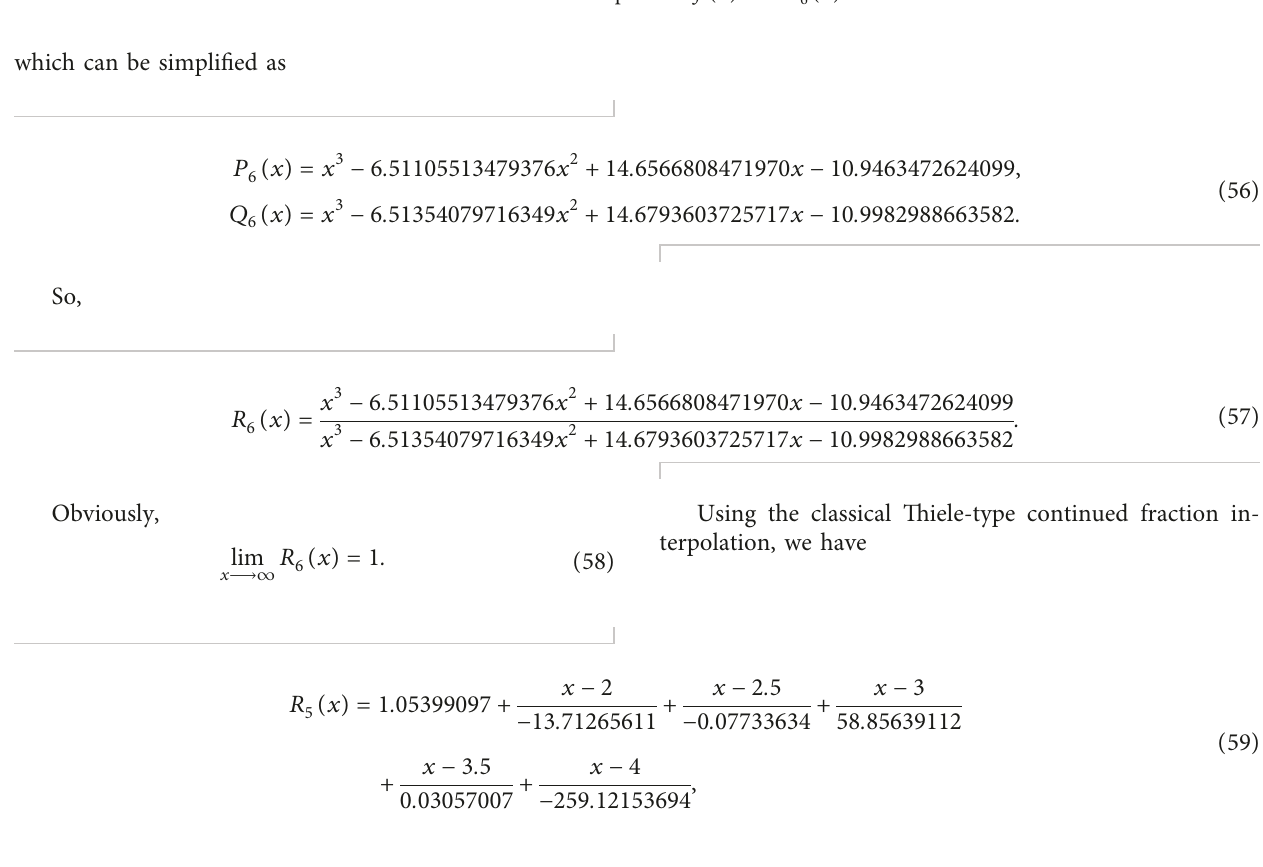
Figure 5: Function plots of f ( x ) and R